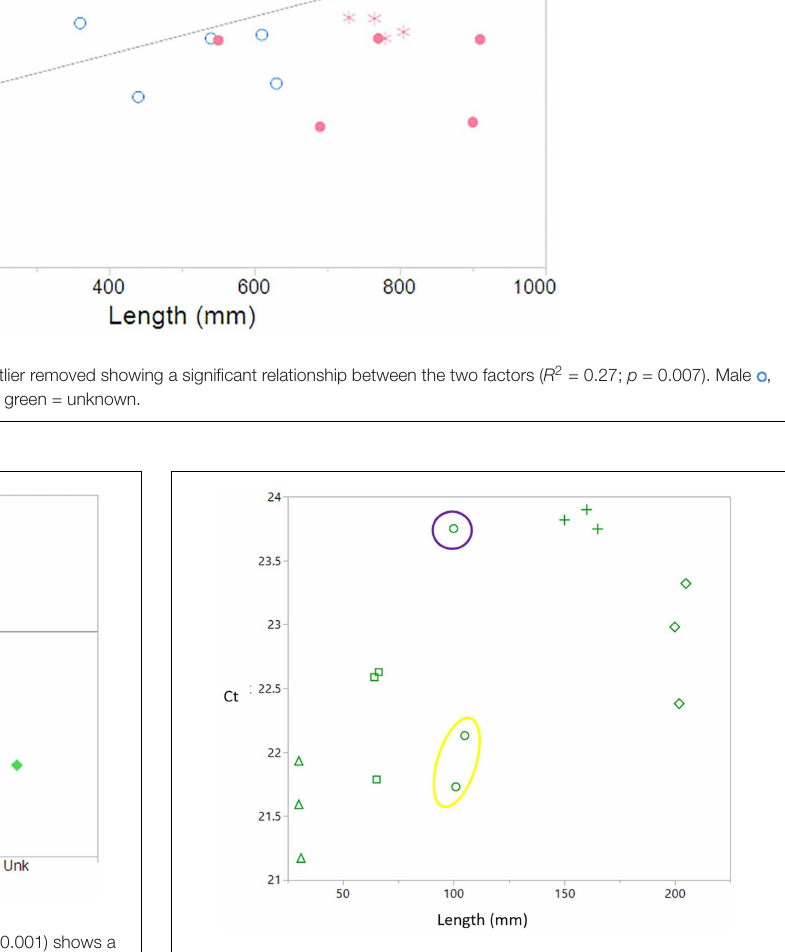
FIGURE 3 | A significant relationship between pup Ct value and length ( R 2 = 0.43, p = 0.008). Each shape defines a different litter. Pups from the litter depicted in circles have a larger spread in Ct values than other litters. The two pups circled in yellow share a sire, while the single individual circled in purple has a different